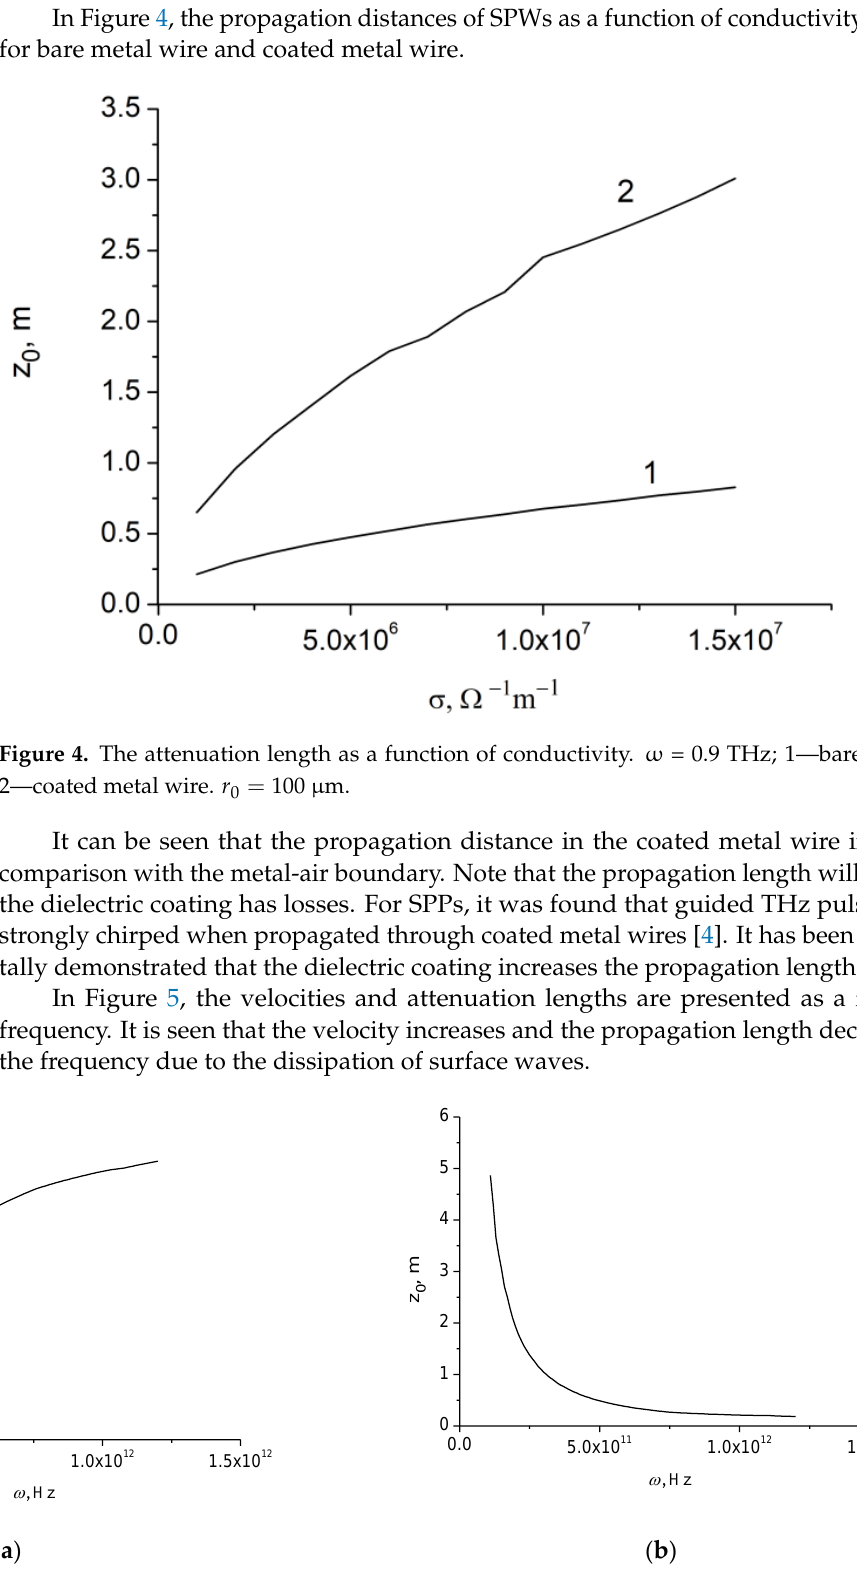
Figure 5. The phase velocity ( a ) and attenuation length ( b ) as a function of frequency. r 0 = 10 µ m, σ = 1.5 · 10 7 Ω − 1 m − 1